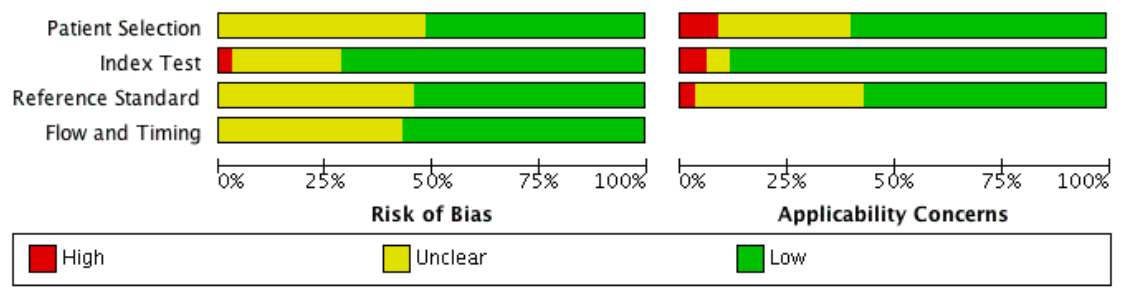
Figure 2. Risk of bias assessment using the QUADAS-2 tool.